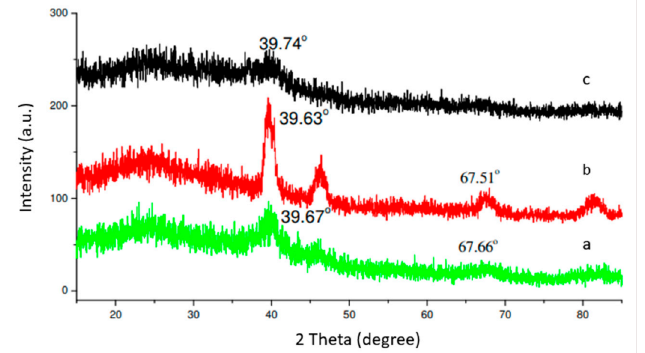
Figure 3. XRD patterns of 60 wt.% PtRu supported on H 2 O 2 -modified carbon black and reduced by NaH 2 PO 2 . ( a ): PtRu/carbon; ( b ): PtRu/carbon-01; ( c ): PtRu/carbon-02.